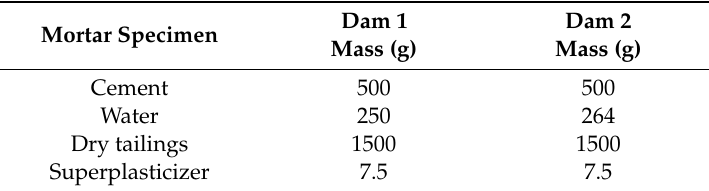
Table 3. Cement, tailings, water, and superplasticizer dosage for making reference specimens using materials from Dams 1 and 2.